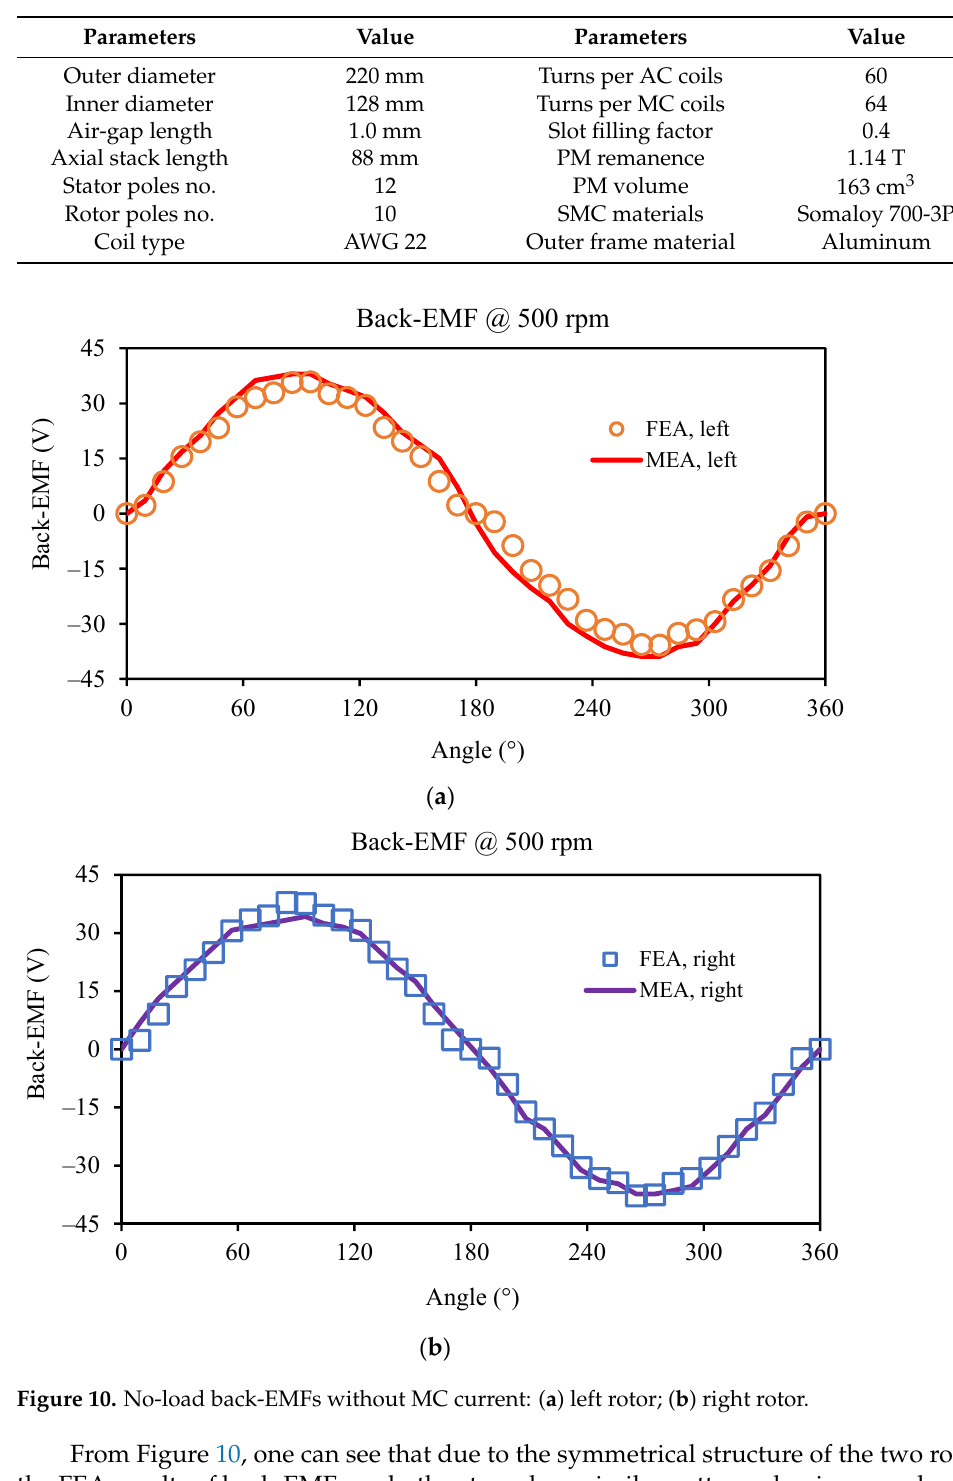
Figure 9. Experiment setup of the testbed. Table 3. Design parameters of the prototype. Table 3. Design parameters of the prototype.